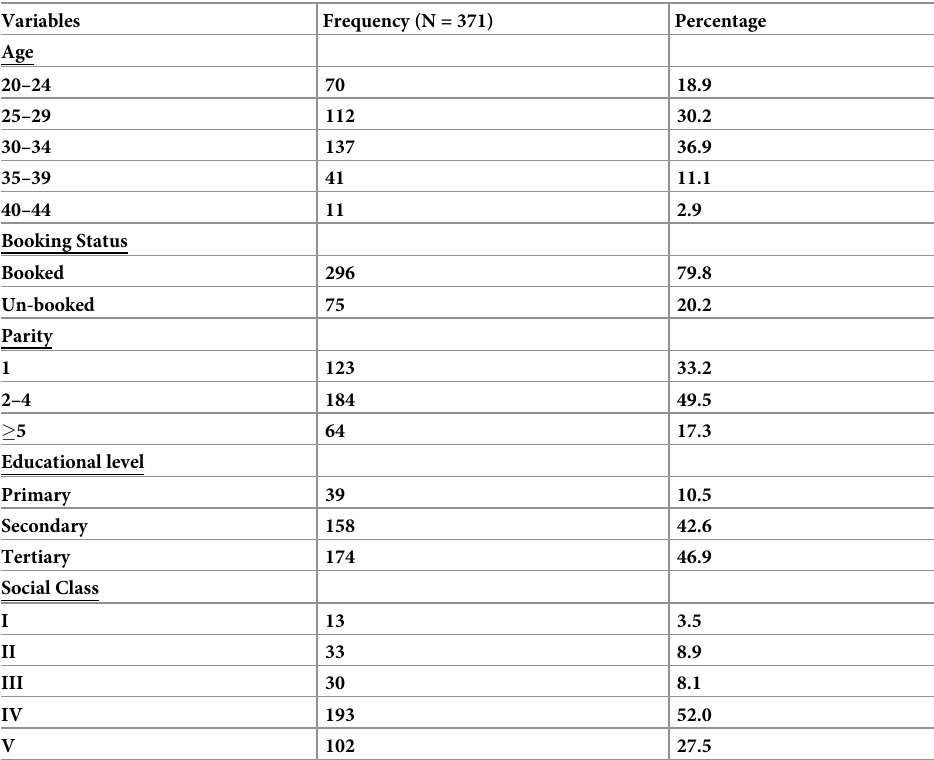
Table 1. Socio-demographic characteristics of the